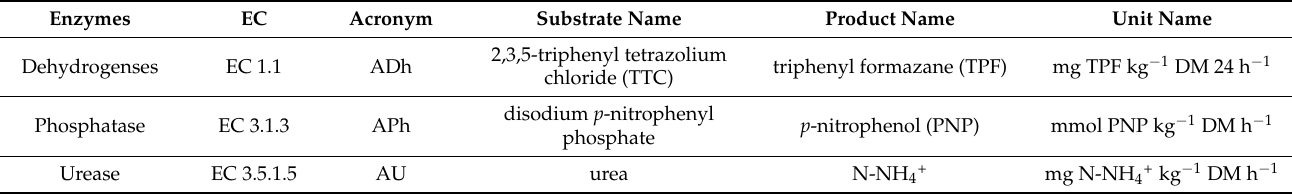
Table 2. Determination of the activity of soil